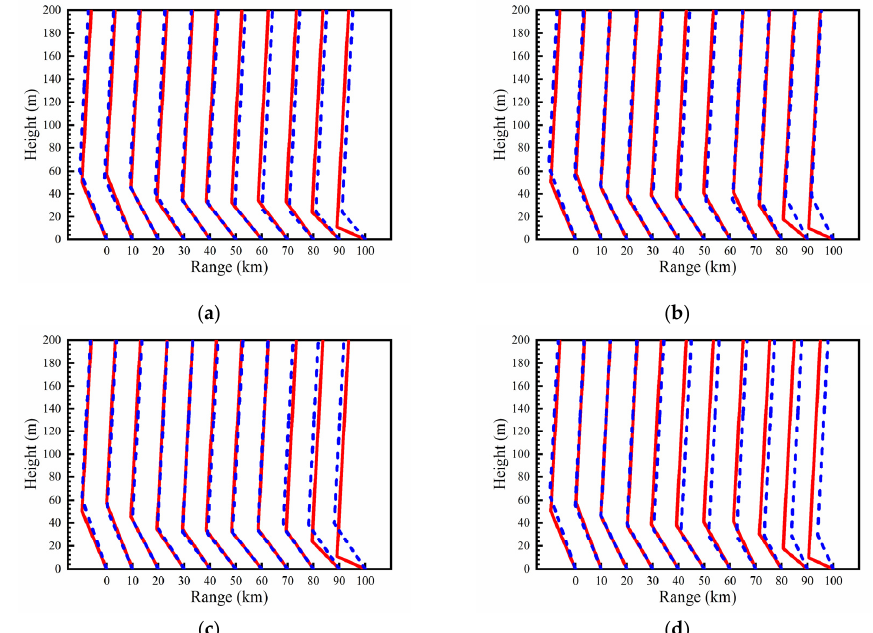
Figure 17. The M profiles pre-estimated using the estimated duct parameters and calculated using the inverted duct parameters at different satellite elevation angle and SNR cases: ( a ) the satellite elevation angle is 8.2° and the SNR is 15 dB; ( b ) the satellite elevation angle is 31.1° and the SNR is 15 dB; ( c ) the satellite elevation angle is 8.2° and the SNR is 5 dB; and ( d ) the satellite elevation angle is 31.1° and the SNR is 5 dB.